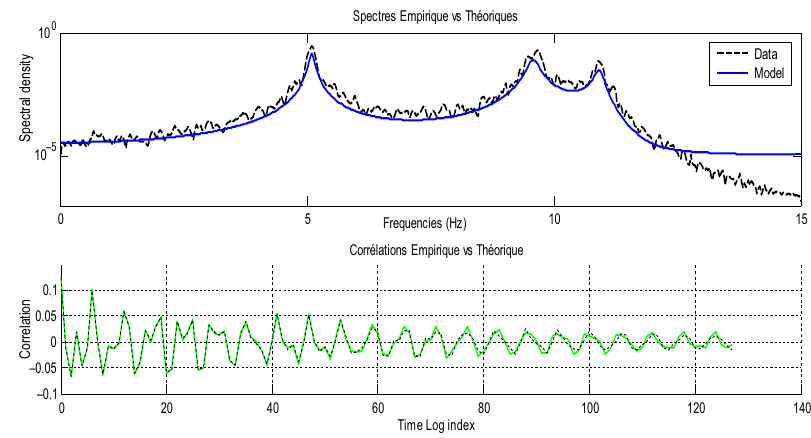
Fig. 8. Cross spectrum between sensors 5 and 20 of the Geiger dome